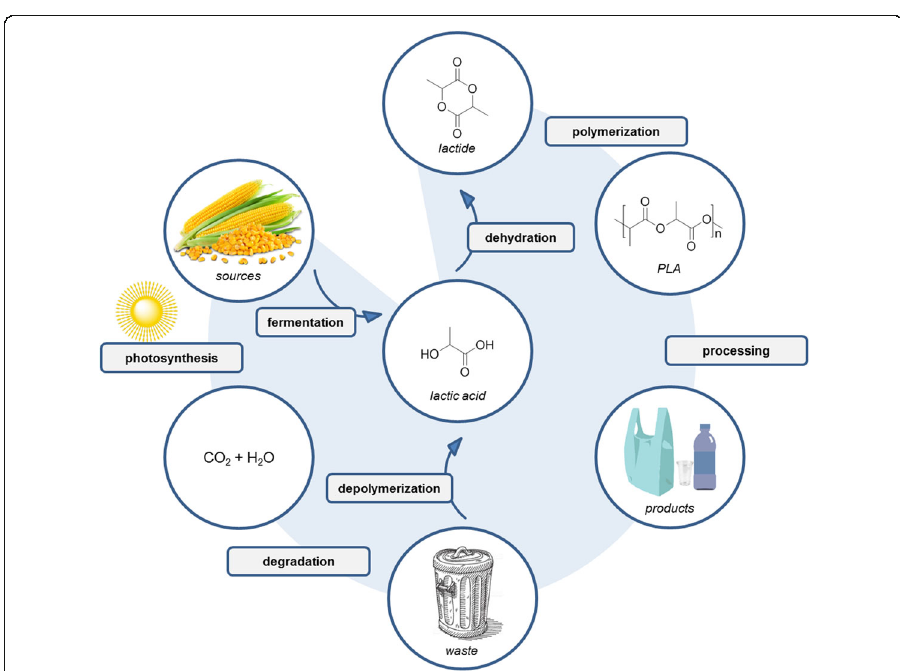
Fig. 3 The LCA of PLA